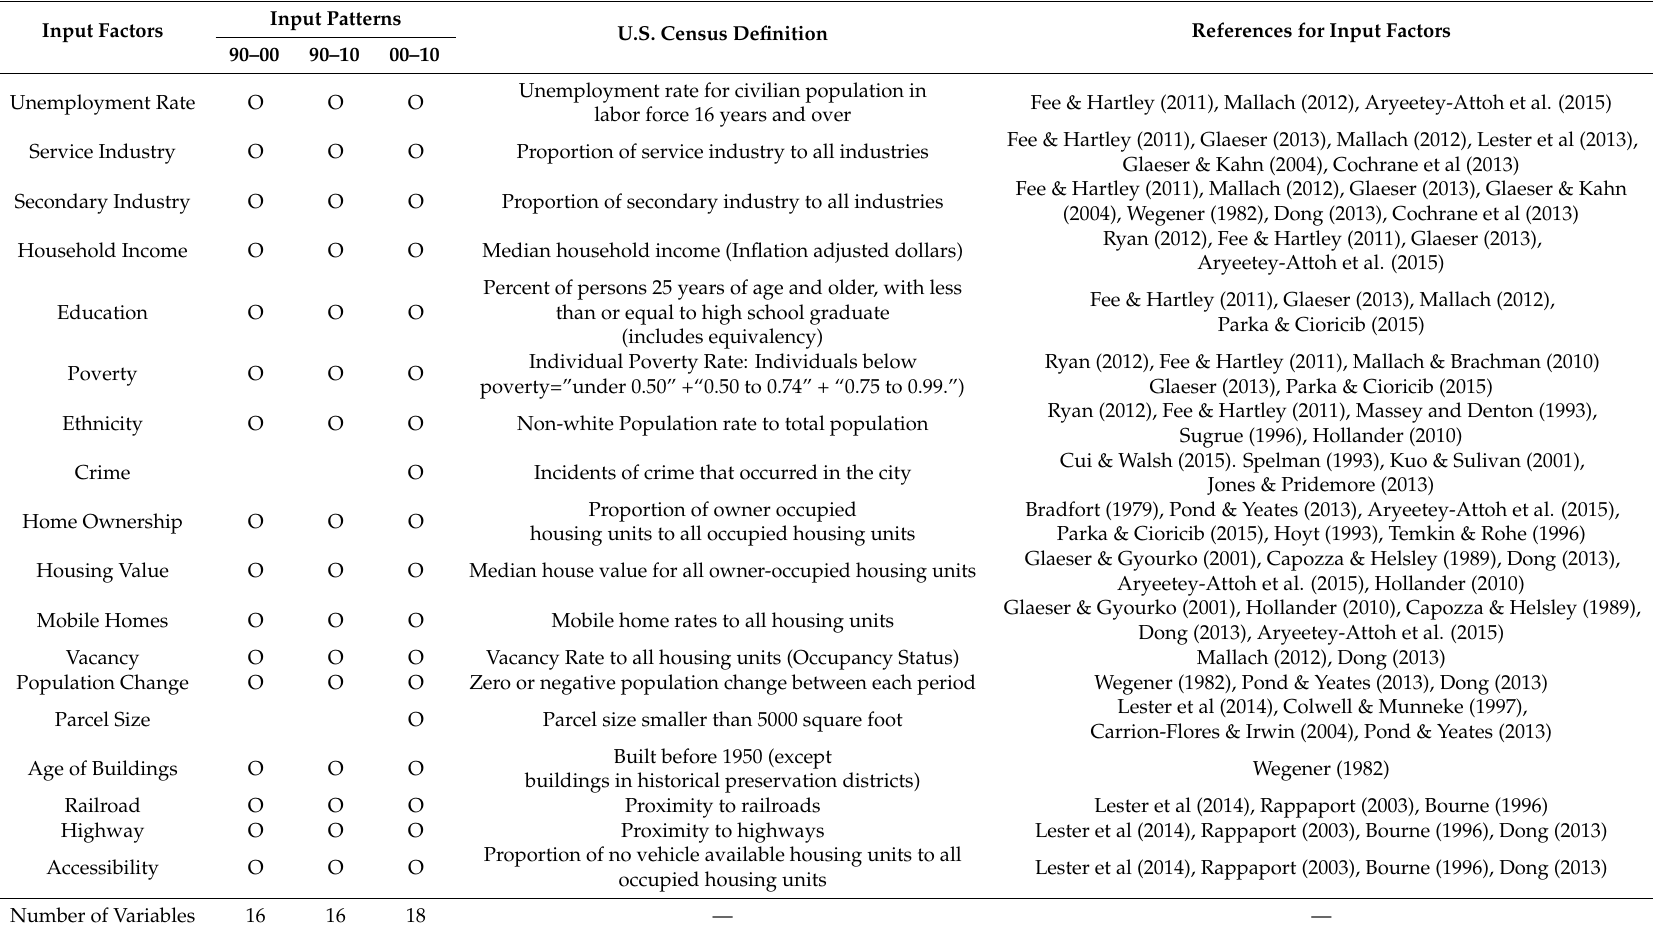
Table 2. Years examined, description, and previous research on input factors utilized as drivers for vacant land